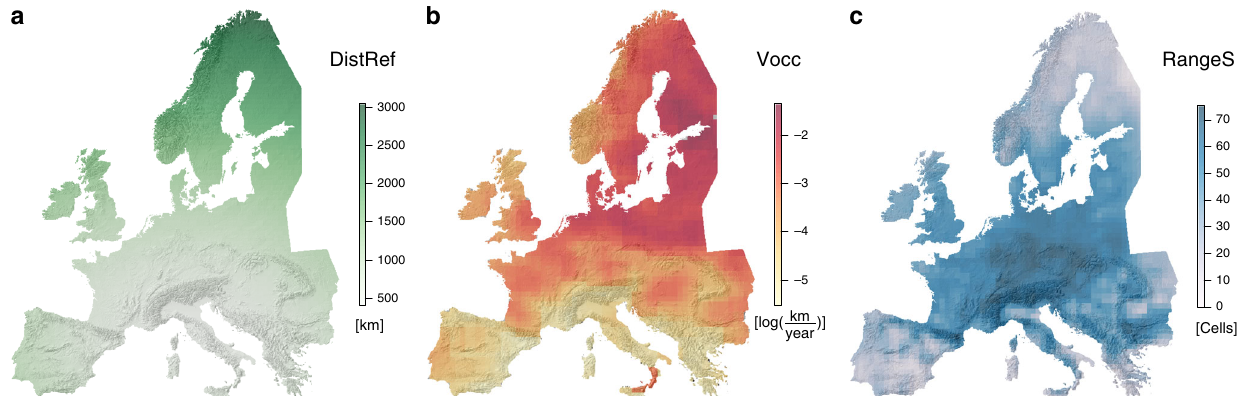
Fig. 3 Explanatory variables of angiosperm phylo- β simC . a Mean distance to refugia (DistRef) of angiosperms was calculated as the average distance among all species per cell to its reconstructed LGM distribution limits (see Fig. 4 for species ’ LGM distributions). b The velocity of climate change (Vocc) since the LGM was calculated based on 1000-year time steps of reconstructed temperature and precipitation trends since the LGM. Vocc considers both the rate of climate change and the rate of elevation change of the local topography and thus expresses the average spatial change of climatic variables over time from the LGM to the present. c Mean range size (RangeS) of the local species pool of angiosperms that was calculated as the average range size of all species per cell across their European distribution as mapped in the Atlas Florae Europaeae. The underlying hillshade maps of Europe are based on the digital elevation model of the European Environment Agency 81 .